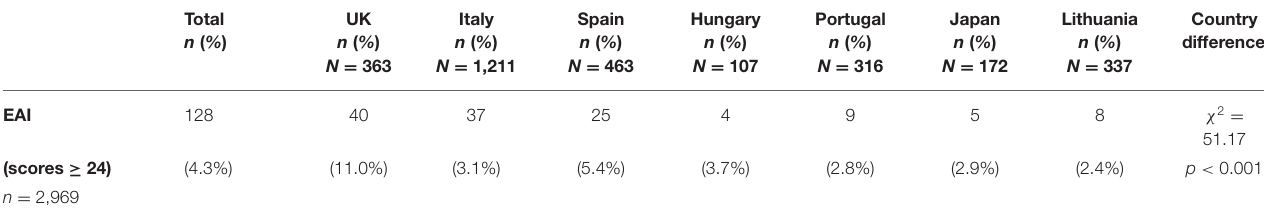
TABLE 3 | Use of fitness supplements (IPEDs): total and by country.